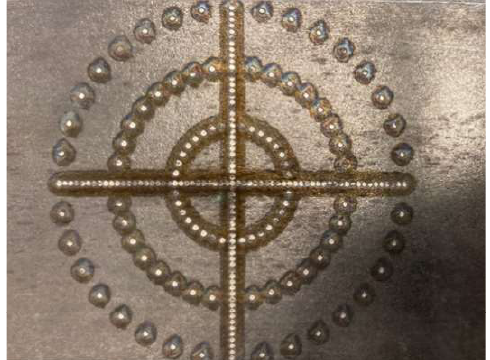
Figure 5. Image of the sample after the transmission measurement showing the ablation marks on the generation side.